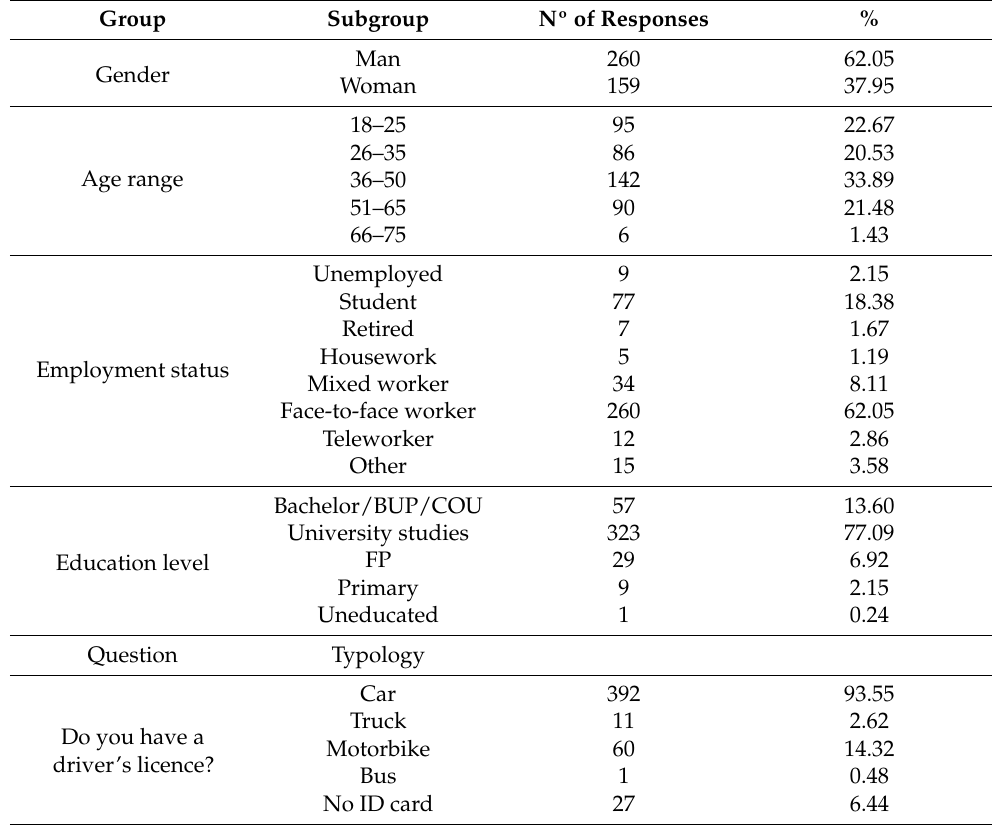
Table 1. Socio-demographic